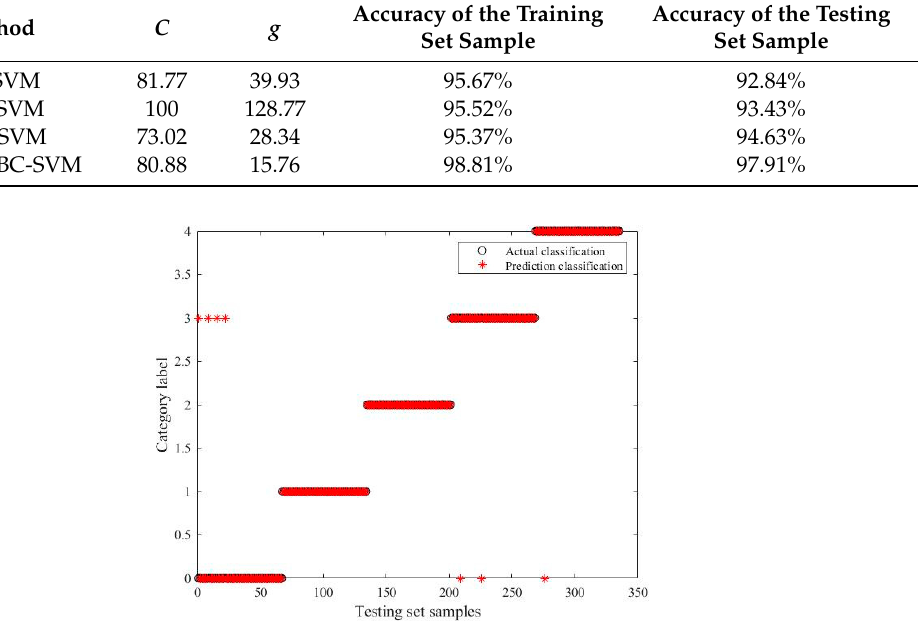
Figure 13. The classification results of the PFCM-ABC-SVM method when the Gaussian noise variance is 0.5.